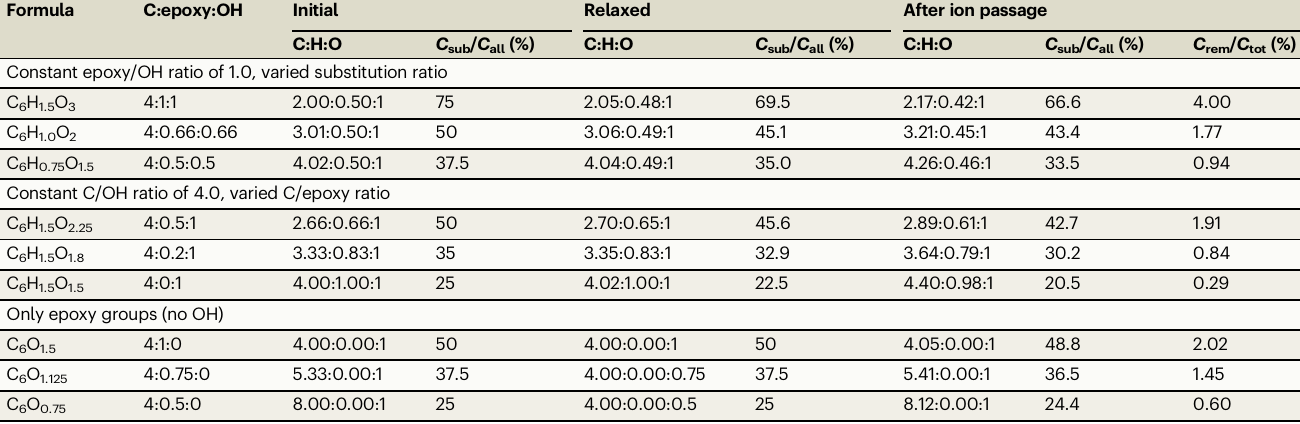
Table 1 | Compositions of single-layer GO models studied with MC-RxMD